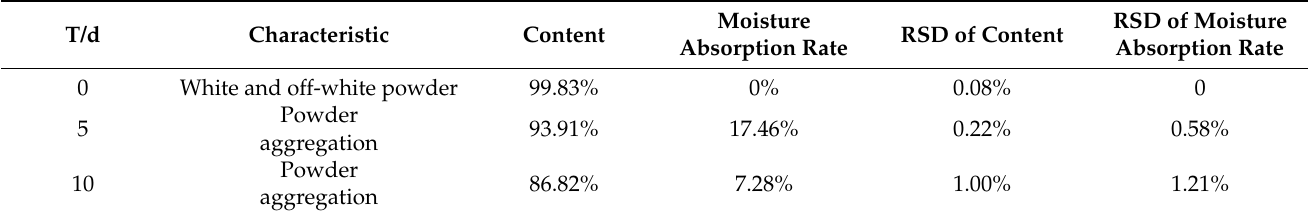
Table 6. The characteristic and moisture absorption under high humidity (saturated KNO 3 solution, RH 90% ± 5%).